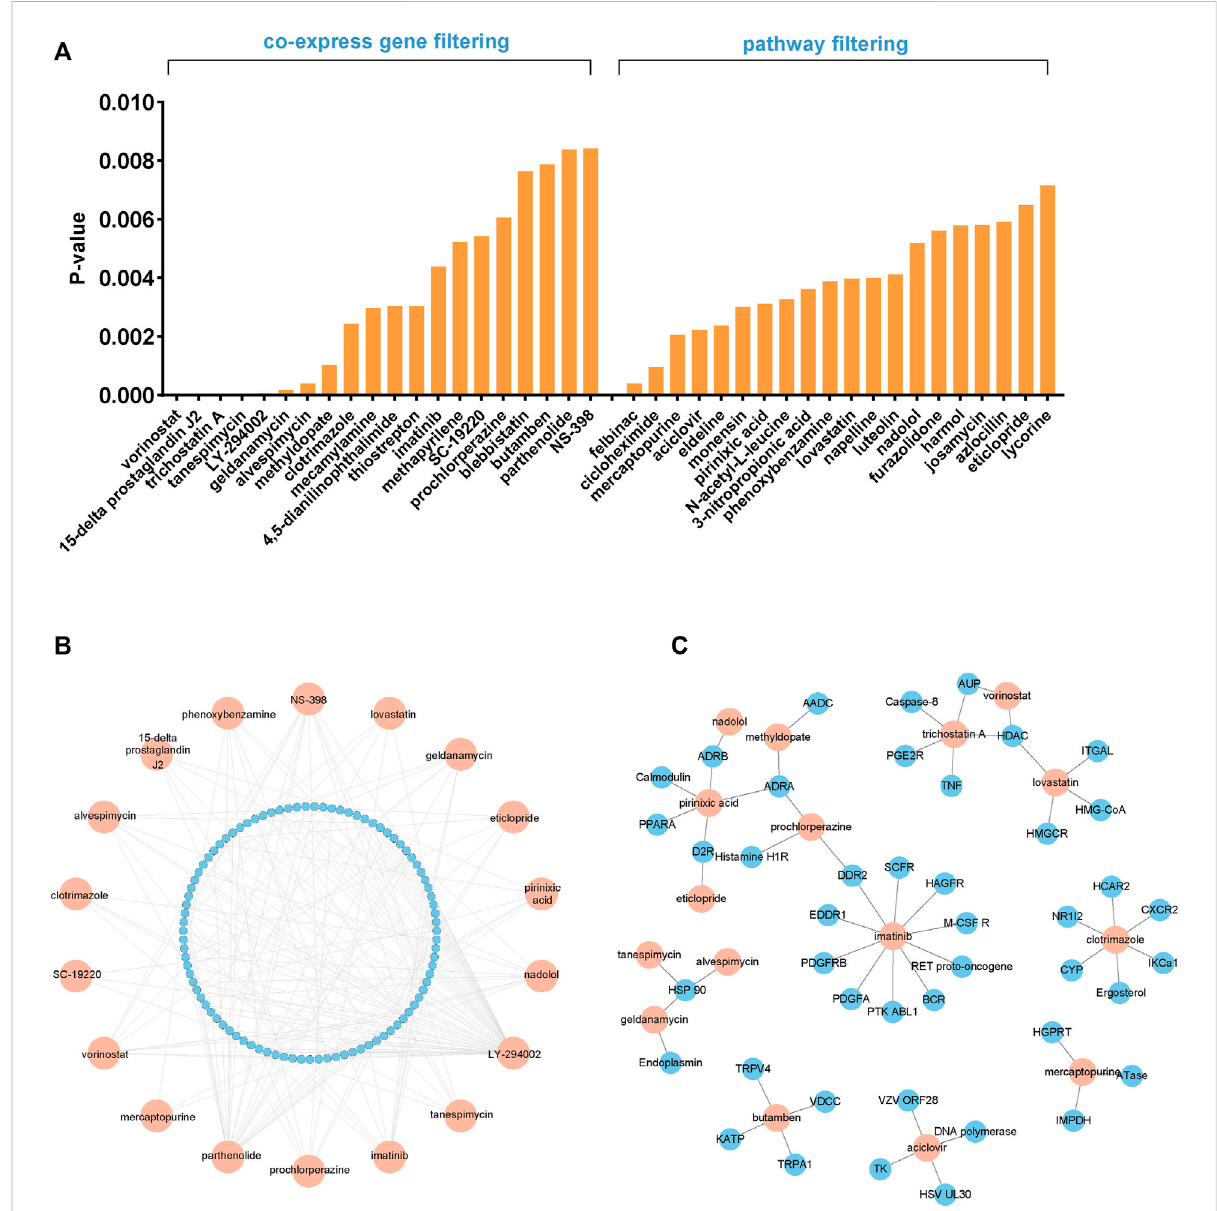
FIGURE 3 ScreeningofthepotentialFGFR4inhibitorcombinations. (A) ThecMapdatabasescreened40potentialcombinationdrugsbasedonFGFR4co- expression genesand enrichment pathways. (B) The TTD explores thepathways ofcandidate drugs. (C) The Drugbank database explores thetargets of candidate